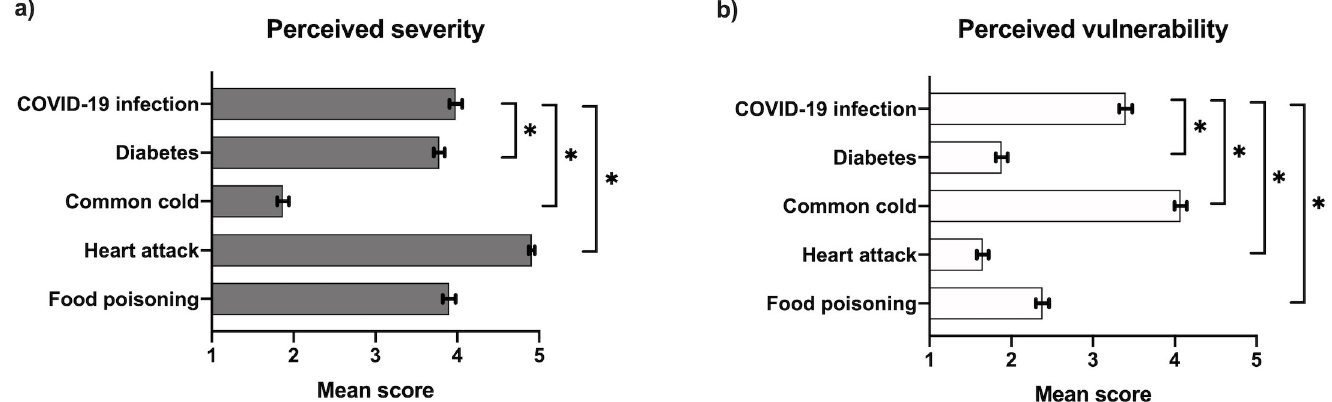
Fig 1. Mean scores of perceived severity and perceived vulnerability (scale 1–5) regarding a COVID-19 infection, common cold, diabetes, heart attack and food poisoning. Note : (a) Perceived severity question: How serious would you rate the following diseases? (b) Perceived vulnerability question: What are the odds that you will get these diseases within a year? Scores: 1 = not at all serious/very unlikely, 2 = not serious/unlikely, 3 = not unserious and not serious/not likely and not unlikely, 4 = serious/likely, 5 = very serious/very likely. Error bars describe 95% confidence intervals. � significance between means for a coronavirus infection compared to the four diseases, p < 0.05,